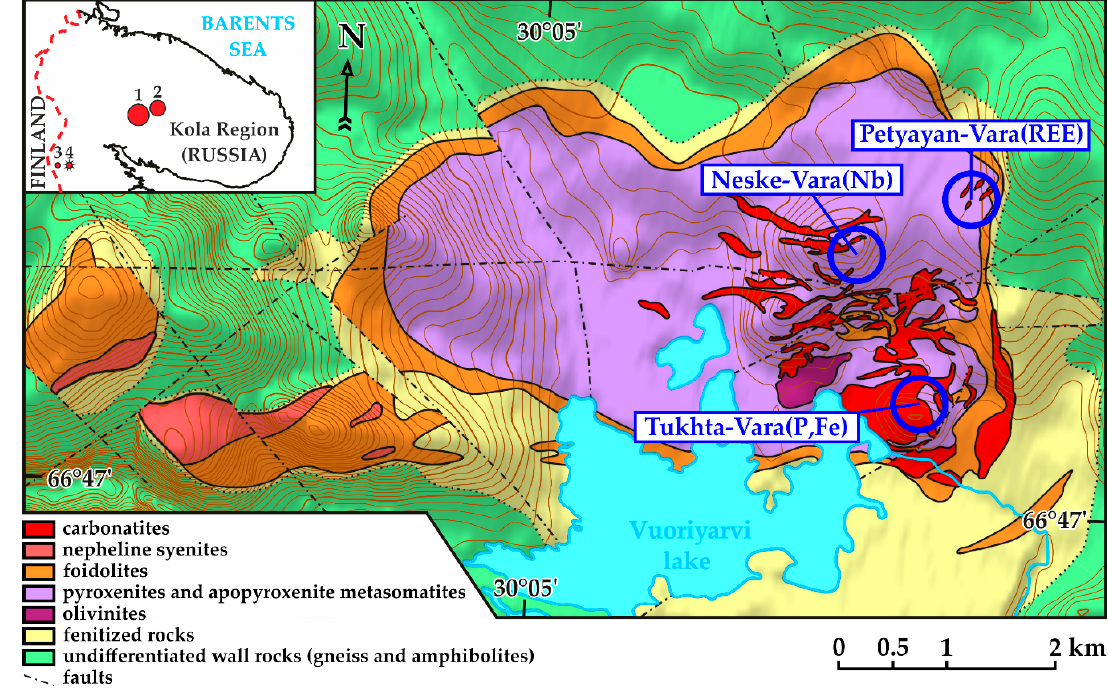
Figure 1. The geological setting and structure of the Vuoriyarvi alkaline–ultramafic carbonatite complex [16]. Blue circles indicate the positions of the Tukhta-Vara, Neske-Vara, and Petyayan-Vara carbonatite fields. The insert shows the position of the REE-rich complexes of the Kola Alkaline Province